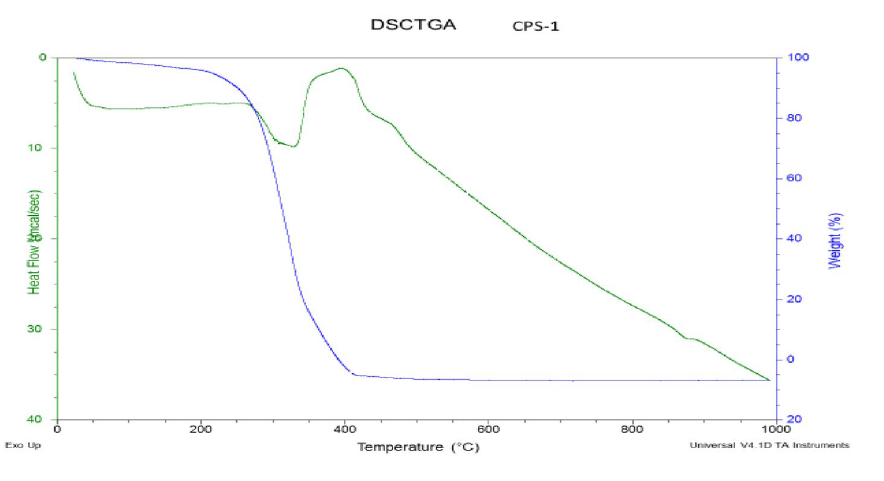
Figure 10. DSC/TGA of